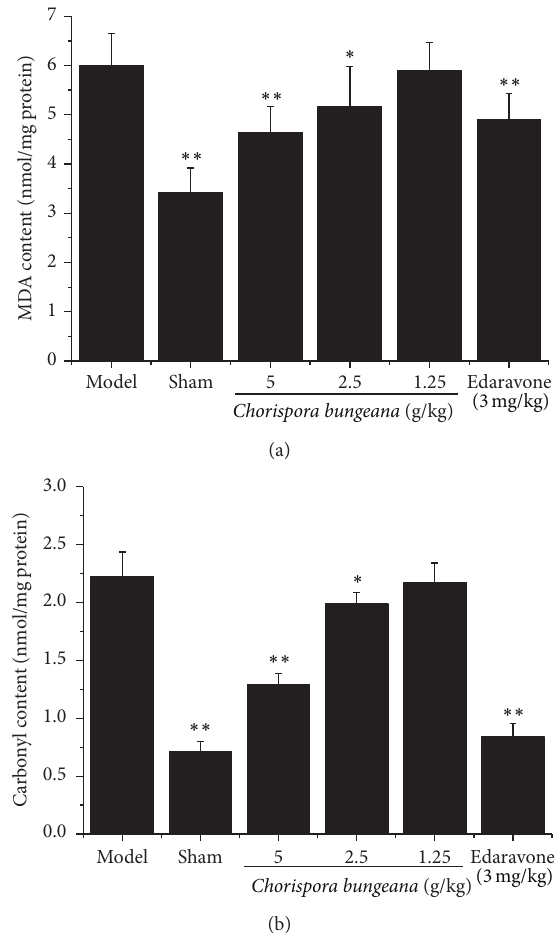
Figure 3: Effect of Chorispora bungeana water extract on MDA (a) and carbonyl (b) in mice subjected to cerebral ischemia/reperfusion. Data were expressed as mean ± S.M.E. Differences were considered significant at 𝑃 < 0.05 . ∗ 𝑃 < 0.05 versus model group. ∗∗ 𝑃 < 0.01 versus model